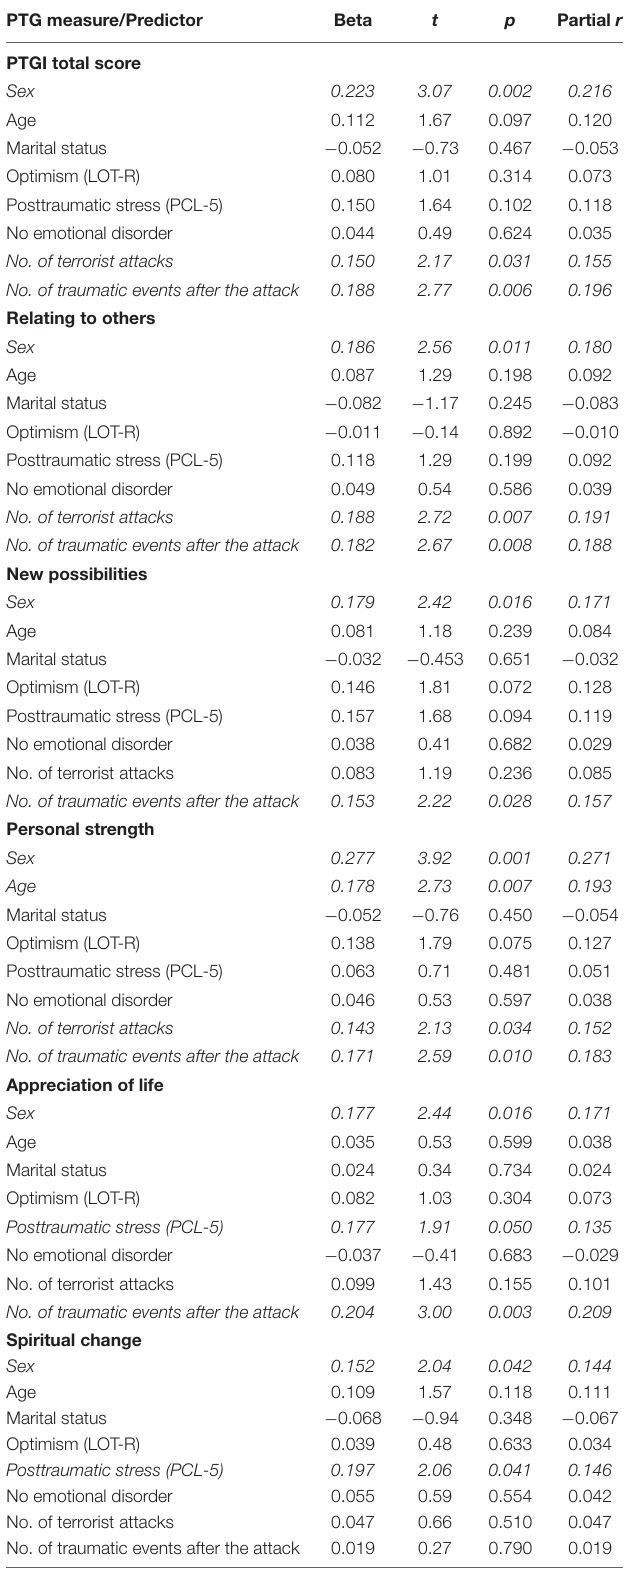
TABLE 4 | Multiple regression analyses on posttraumatic growth (PTG)